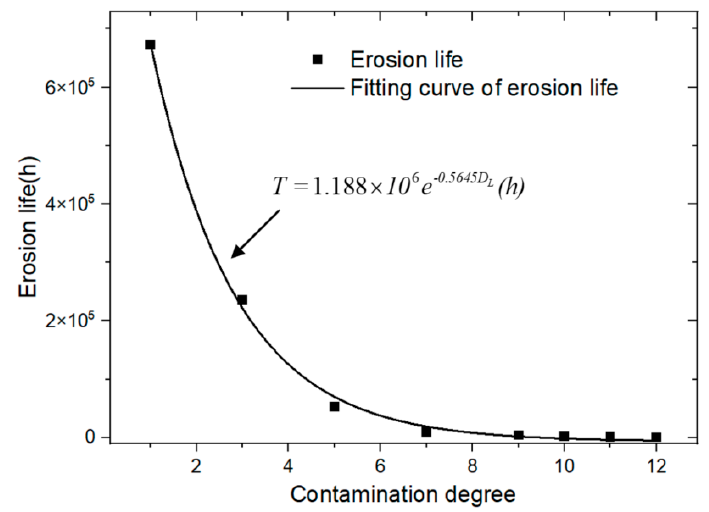
Figure 18. Brake pressures before and after